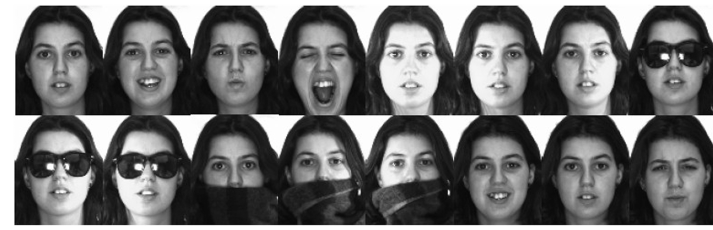
Figure 7. Sample images from the AR Face Dataset.